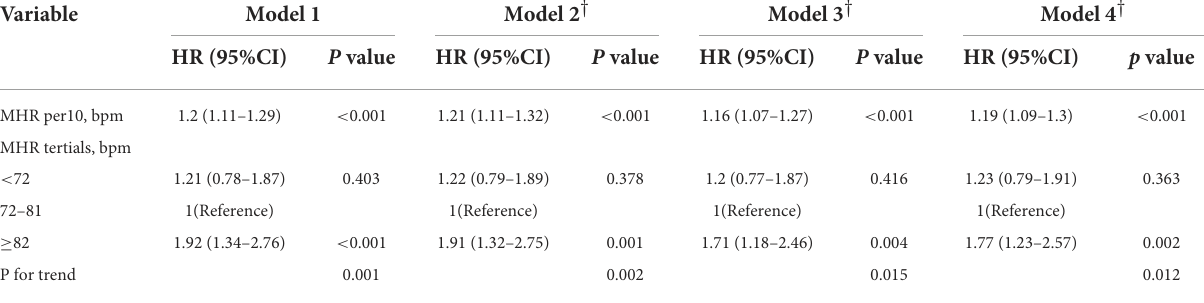
TABLE 2 Hazard ratio and 95% CI of mean heart rate for 30-day mortality.